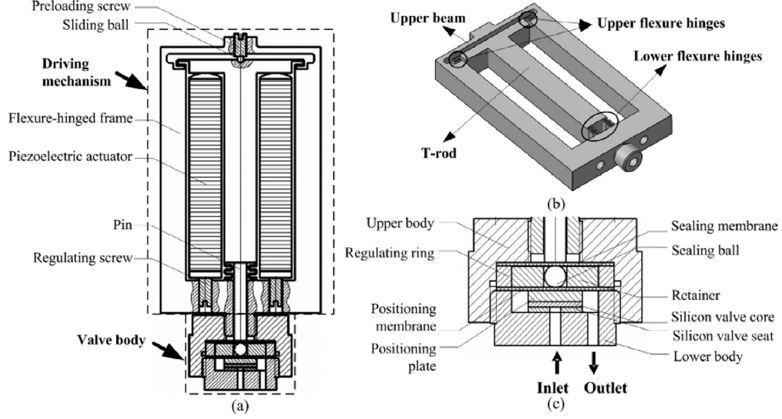
Figure 6. Schematic structure of the microvalve [44]: ( a ) The structure of the microvalve; ( b ) The diagram of the 3D geometry model of the frame; ( c ) The cross-sectional view of the valve body.